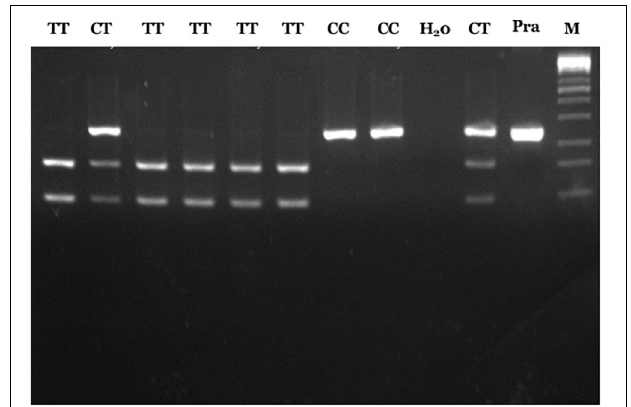
FIGURE 1 | PCR-RFLP results of RET rs2435357 variant. Lane 1, 3–6: TT genotype (156 and 90 bp); lane 2, 10: CT genotype (246, 156, and 90 bp), lane 7–8: CC genotype (246 bp), lane 9: H 2 0, lane 11: pra-digested PCR, and lane M: 100 bp DNA marker.